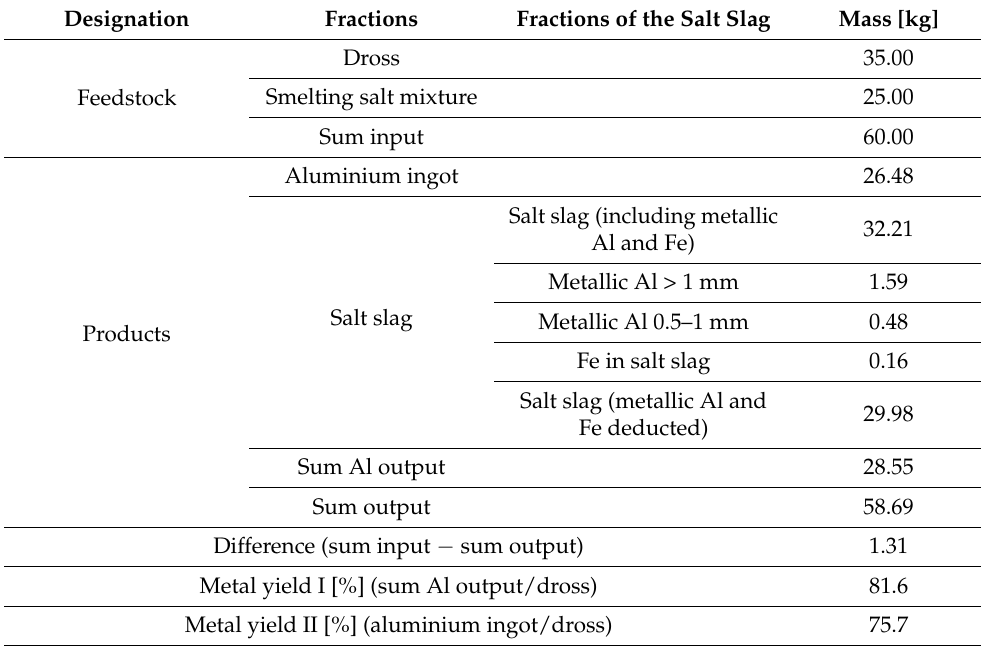
Table 2. Mass balance of the melting experiment in the